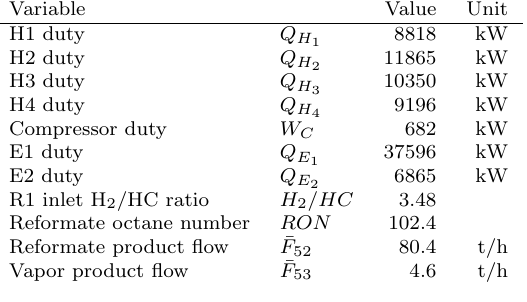
94.57% and 5.43%, respectively, where the latter